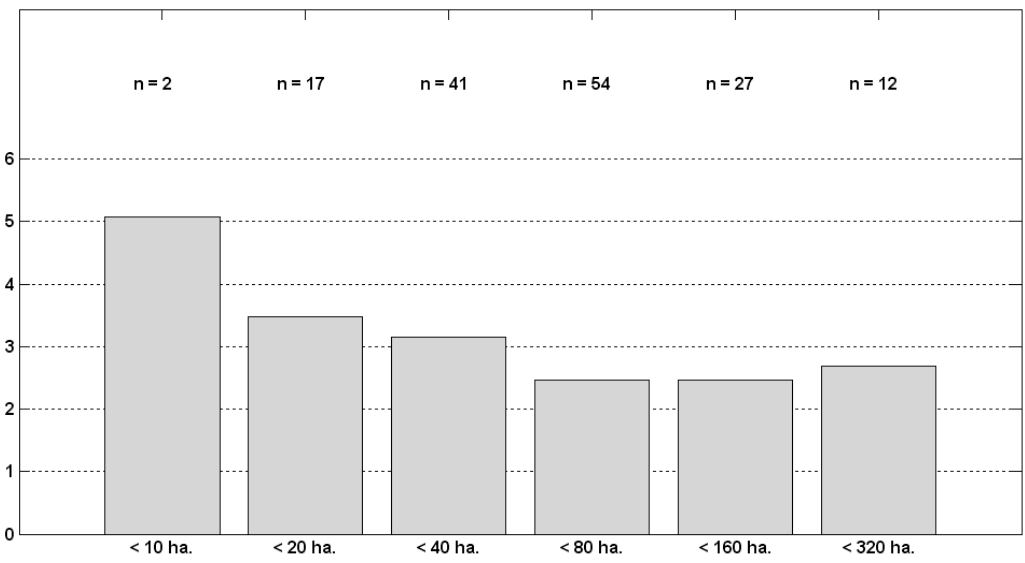
Figure A2.1: Cattle stocking density in head/ha as a function of property size. The n for each bar represents the number of admissable survey responses used to derive the result.